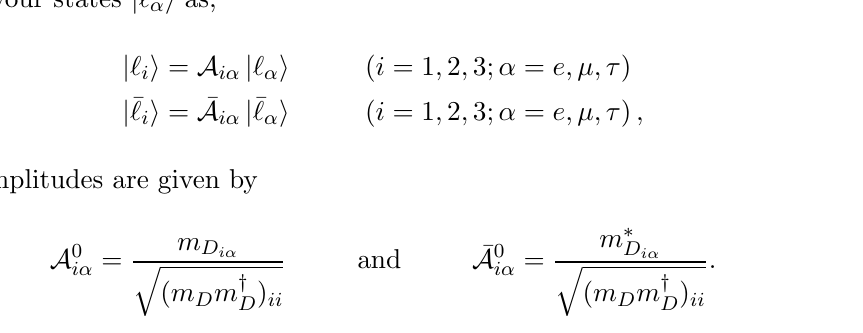
enables us to extract information regarding N 12